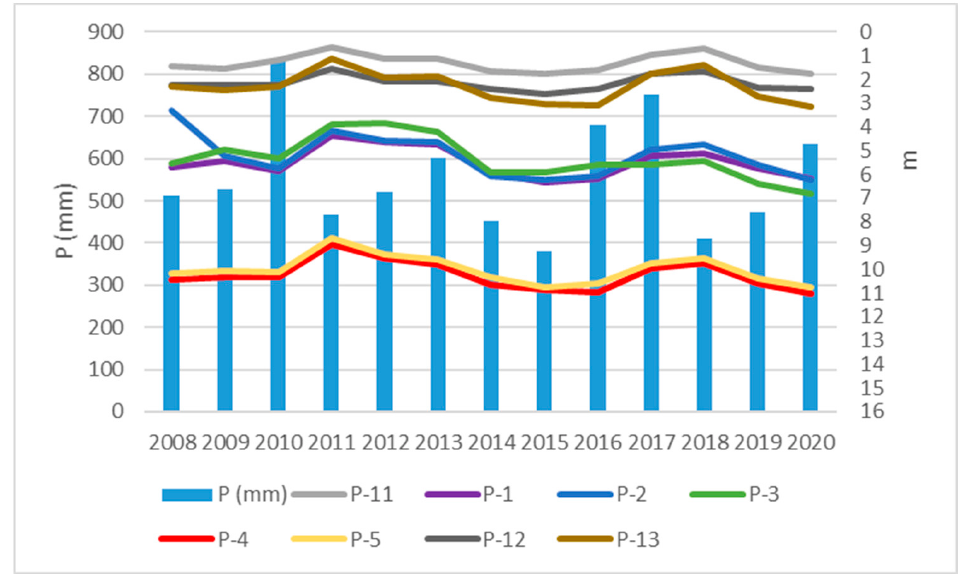
Figure 15. The highest water table levels in piezometers in comparison with annual precipitation totals in the period 2008–2020.